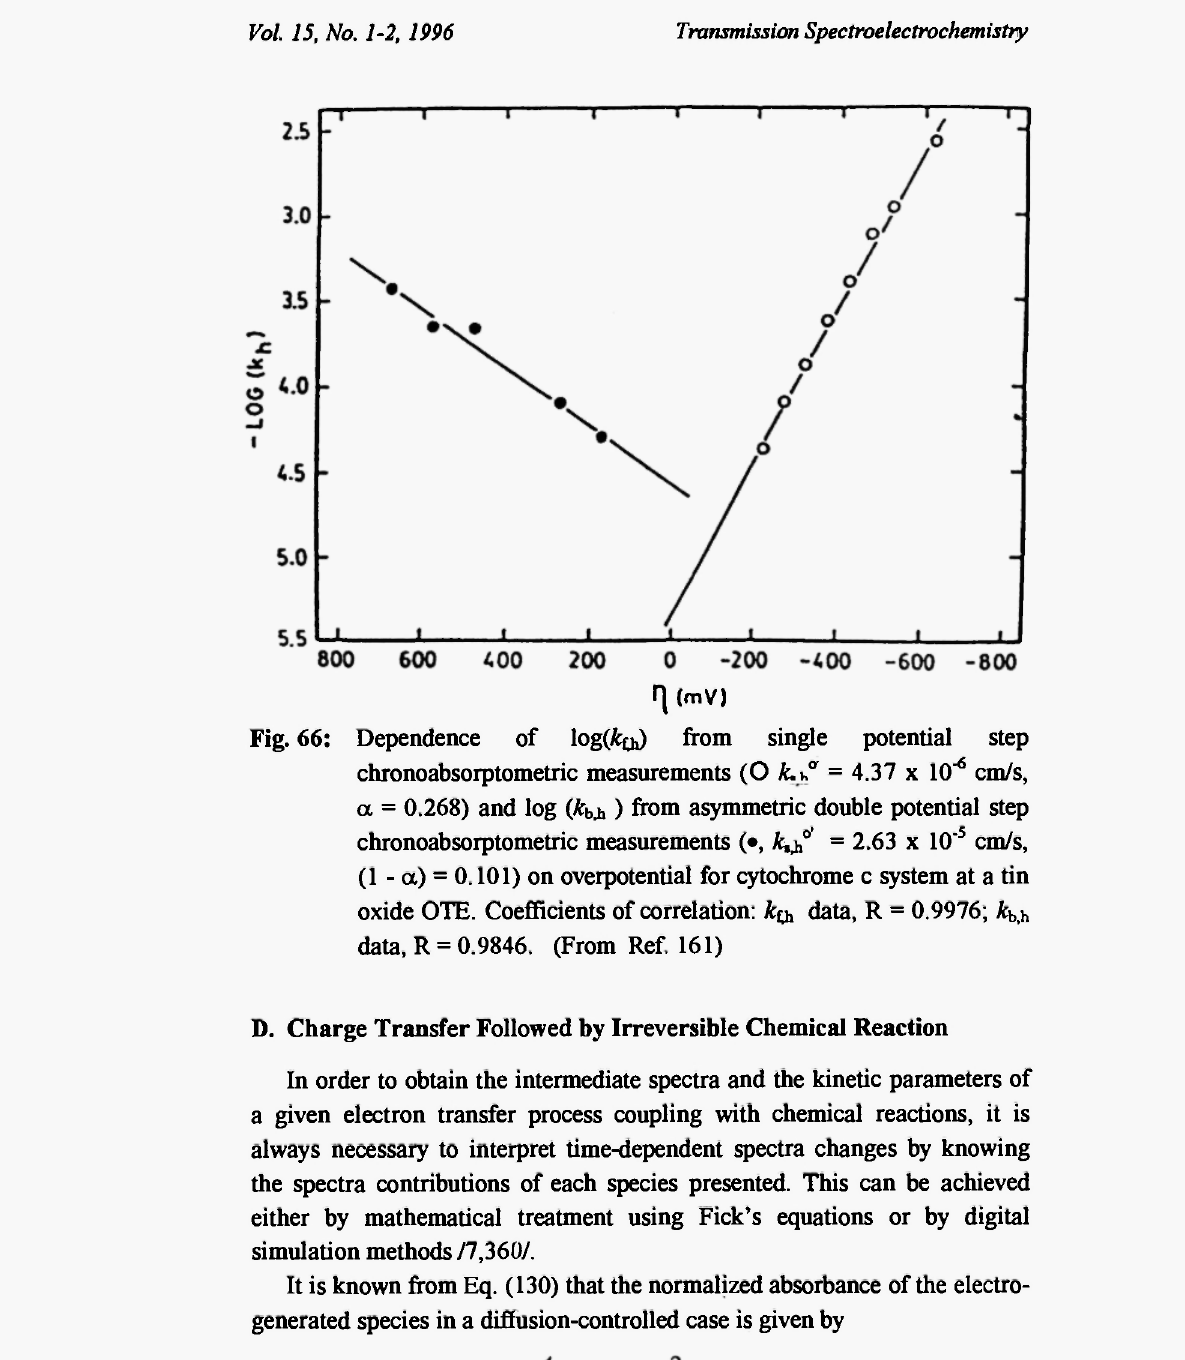
f](mV) Fig. 66: Dependence of log(%) from single potential step chronoabsorptometric measurements (O = 4.37 χ 10" 6 cm/s, α = 0.268) and log ) from asymmetric double potential step chronoabsorptometric measurements (·, k,^ 0 ' = 2.63 χ 10 s cm/s, (1 - a) = 0.101) on overpotential for cytochrome c system at a tin oxide OTE. Coefficients of correlation: % data, R = 0.9976; k byh data, R = 0.9846. (From Ref.